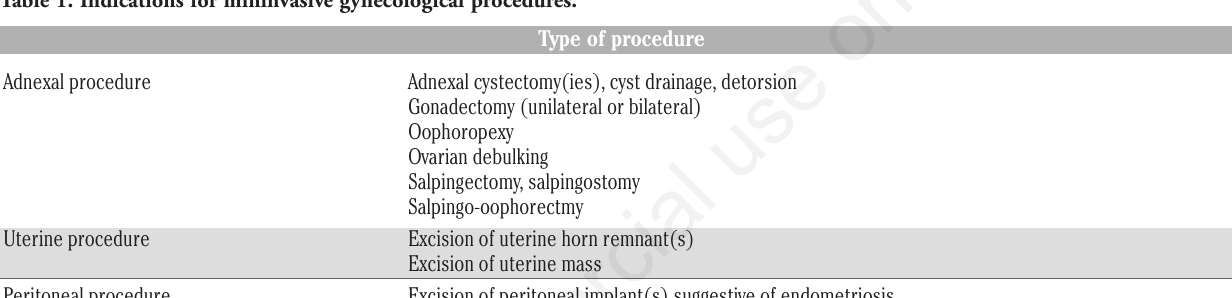
Table 1. Indications for mininvasive gynecological procedures.